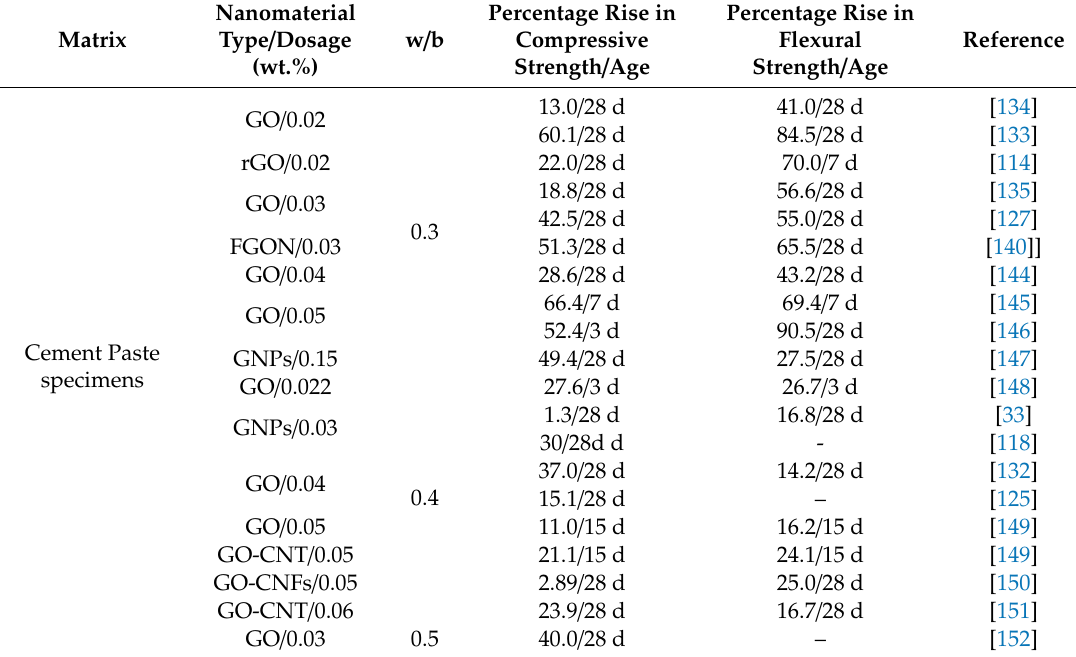
Table 3. The impact of graphene based nanomaterials on the mechanical properties of cement composite modified from